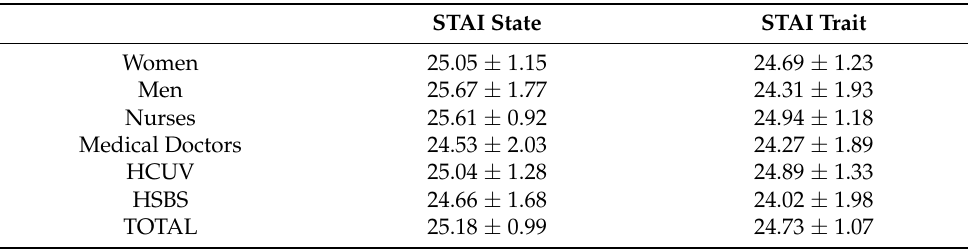
Table 2. STAI scores (state and trait) regarding gender, professional status (nurses and medical doctors) and hospitals.